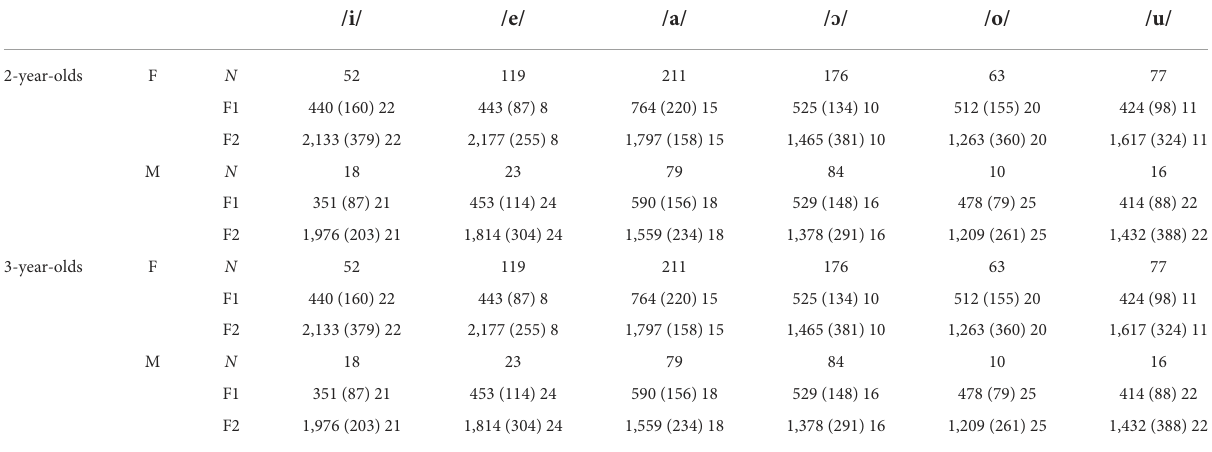
TABLE 4 Number of tokens and formant values for the six Nungon vowels in CDS. /i/ /e/ /a/ / O / /o/ /u/